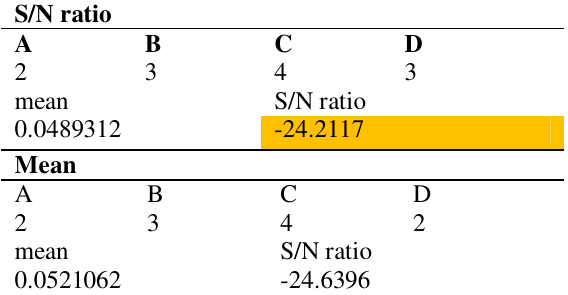
The prediction of the mean and S/N ratio.